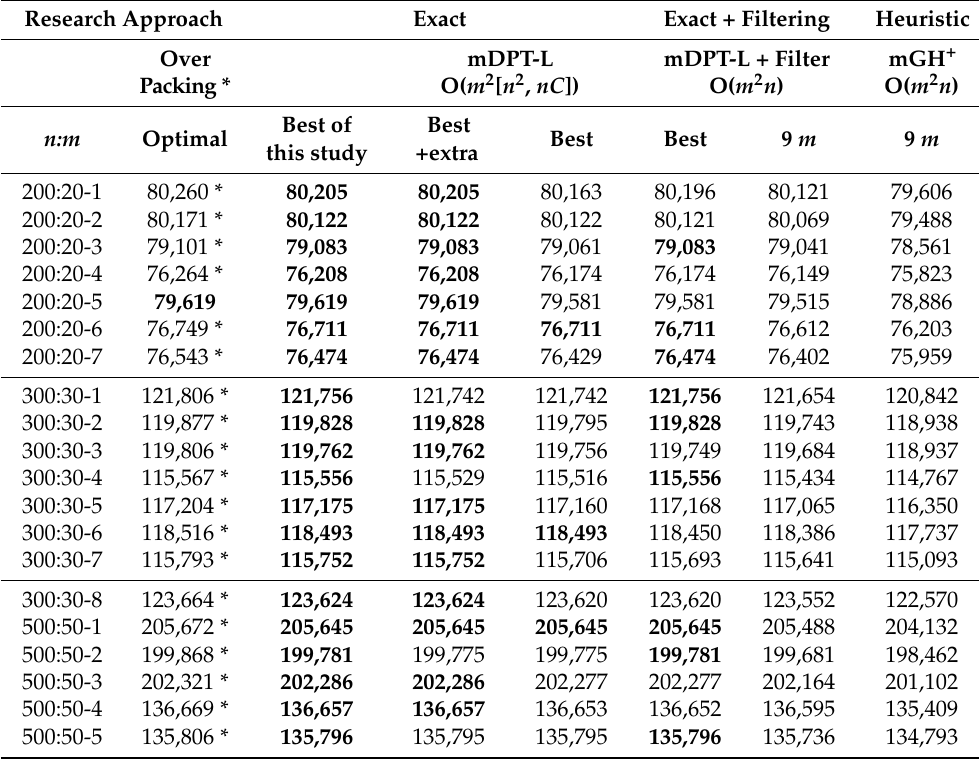
Table 13. Results (total profits) of 20 benchmark datasets (200 ≤ n ≤ 500, 20 ≤ m ≤ 50). Research